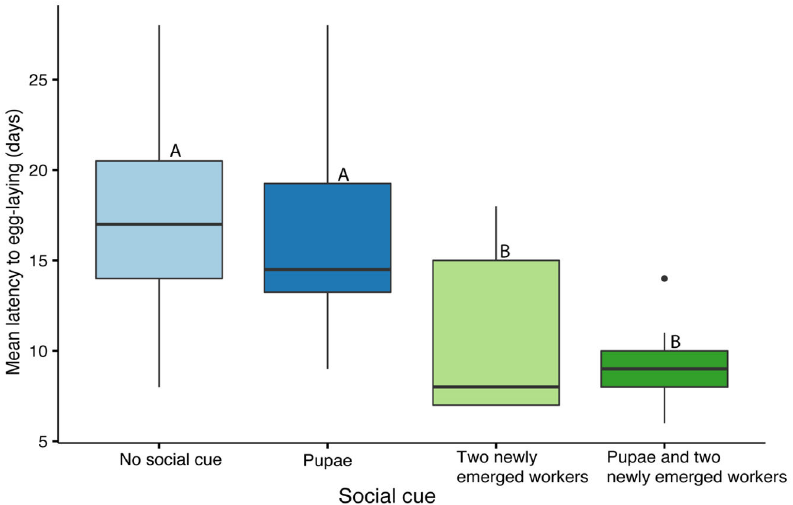
Figure 4. The effect of social cues on colony initiation in Bombus impatiens . Queens ( n = 39/44) were treated with CO 2 and exposed to four different social cues: no social cue ( n = 14), 3–5 fresh pupae ( n = 10), 2 newly emerged workers ( n = 9), and 2 newly emerged workers and 3–5 fresh pupae ( n = 11). Queens were monitored for egg laying for 28 days. Boxplots represent the minimum, lower quartile, median (bolded line), upper quartile, and maximum values; points represent outliers. Different letters indicate statistical differences at α =